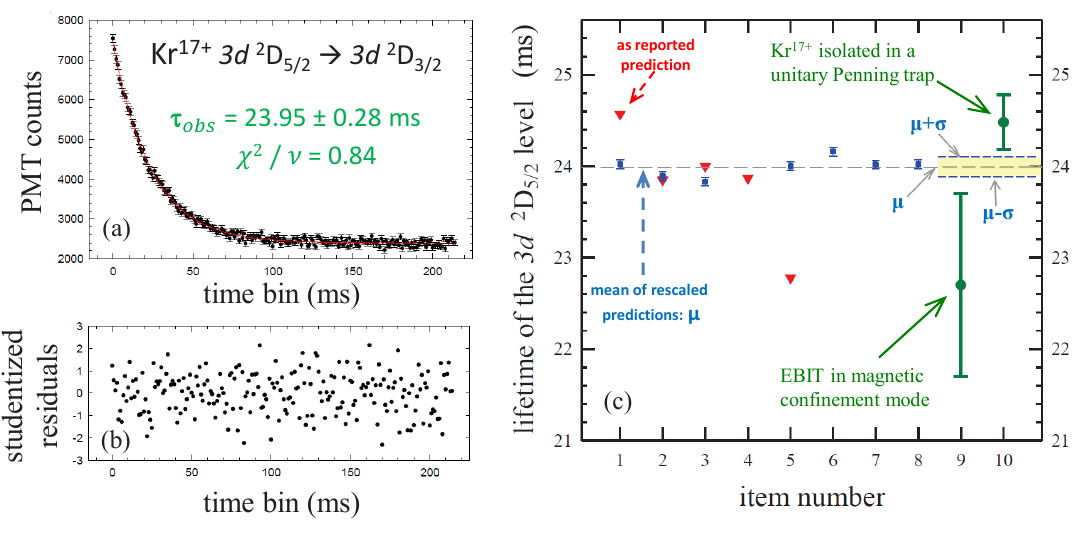
( a ) Photomultiplier signal from Kr 17+ ions captured in a trap with an ambient pressure of 1 . 0 × 10 − 7 Pa ( 8 . 0 × 10 − 10 torr); the red line is the best fit to a single-exponential e − t/τ obs + c ; ( b ) Studentized residuals ( N ( t ) − N decay curve N ( t ) = N 0 fit; ( c ) comparison of measurements (circle) with theoretical values, as reported (triangle) or adjusted (square). Table 1 lists the sources of the items plotted in ( c ). Adapted from Figures 2 and 3 in